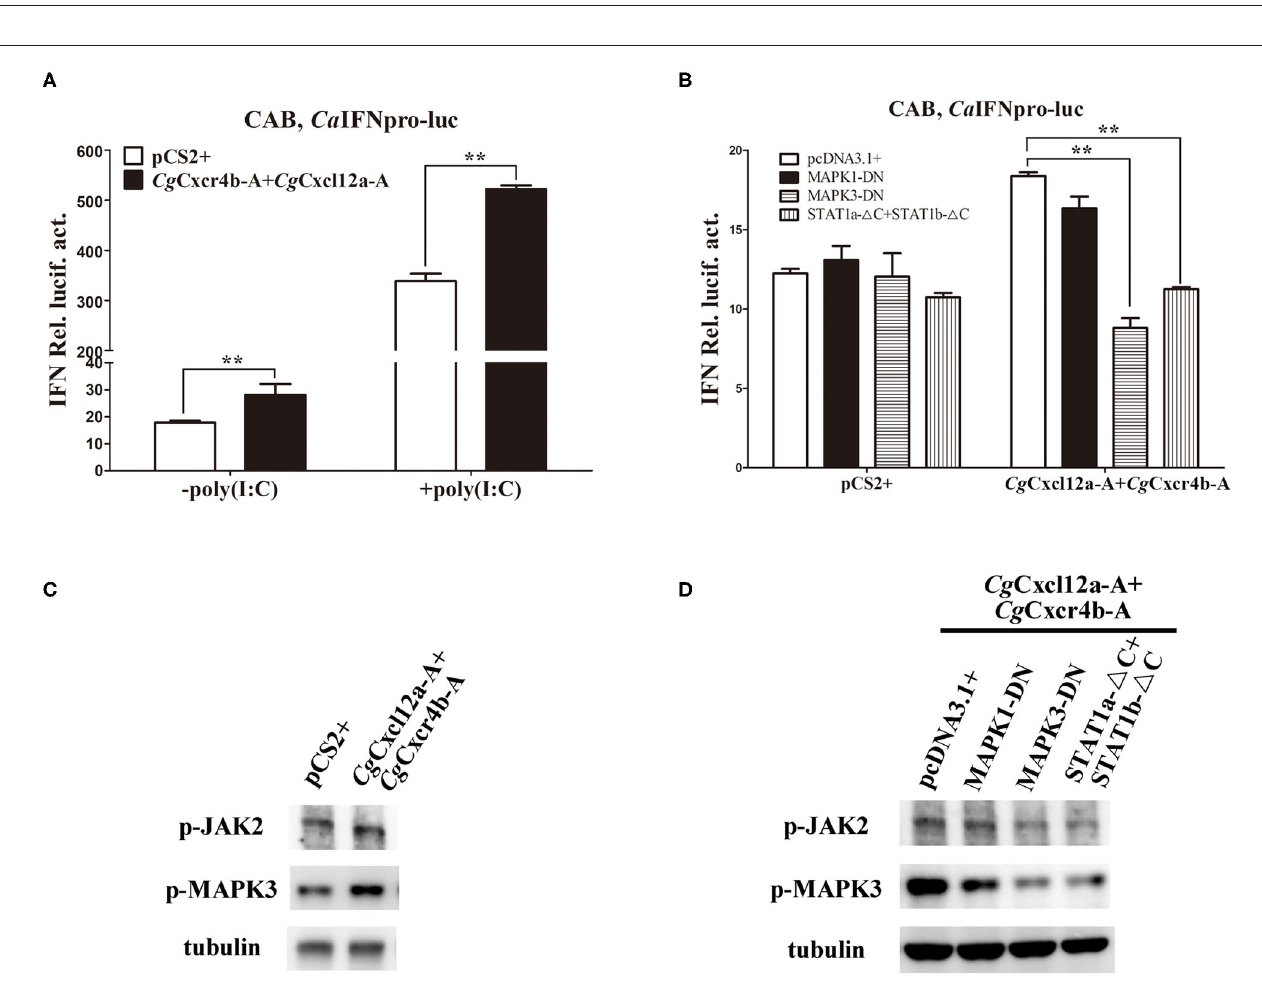
FIGURE 6 | CAB cells after poly(I:C) stimulation. (C) The up-regulation protein expression of p-IRF3, IRF7, and STAT1 were suppressed in AMD3100-treated CAB cells after poly(I:C) stimulation. (D) Poly(I:C)-triggered activation of IFN promoter was enhanced by overexpression of Cxcr4s or Cxcl12s. Each bar represents mean ± SEM ( n = 3). The asterisks indicate the significant differences (* p < 0.05, ** p < 0.01).